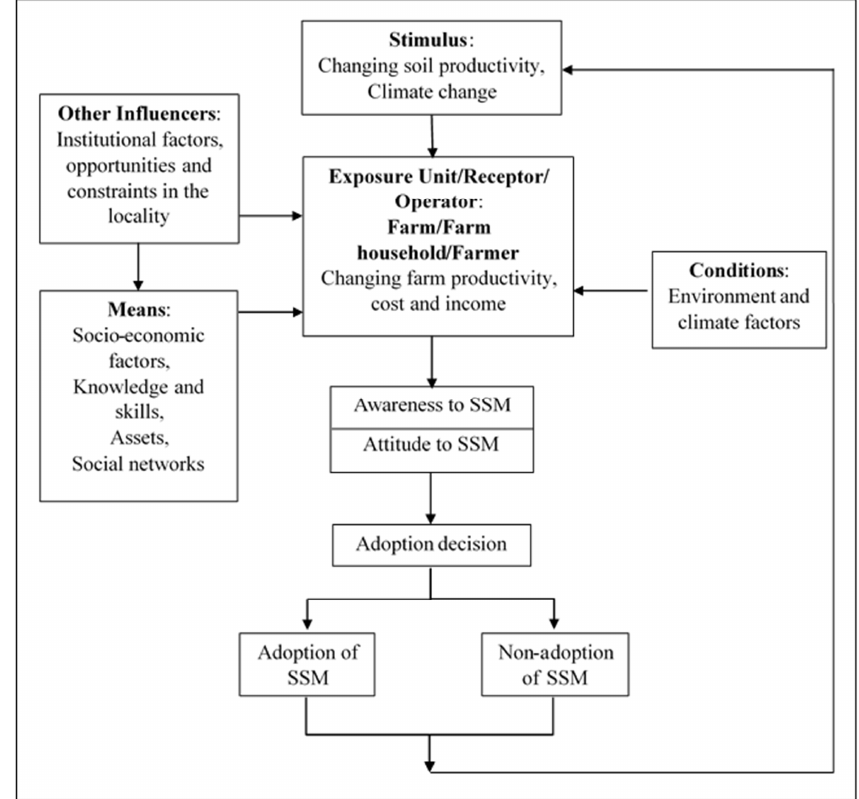
Figure 1. Schematic representation for understanding the farmers’ sustainable soil management adoption behavior. Note: Developed based on Eisenack and Stecke, Reid et al., Neupane et al. and Harris and Bezdicek [52,55–57].